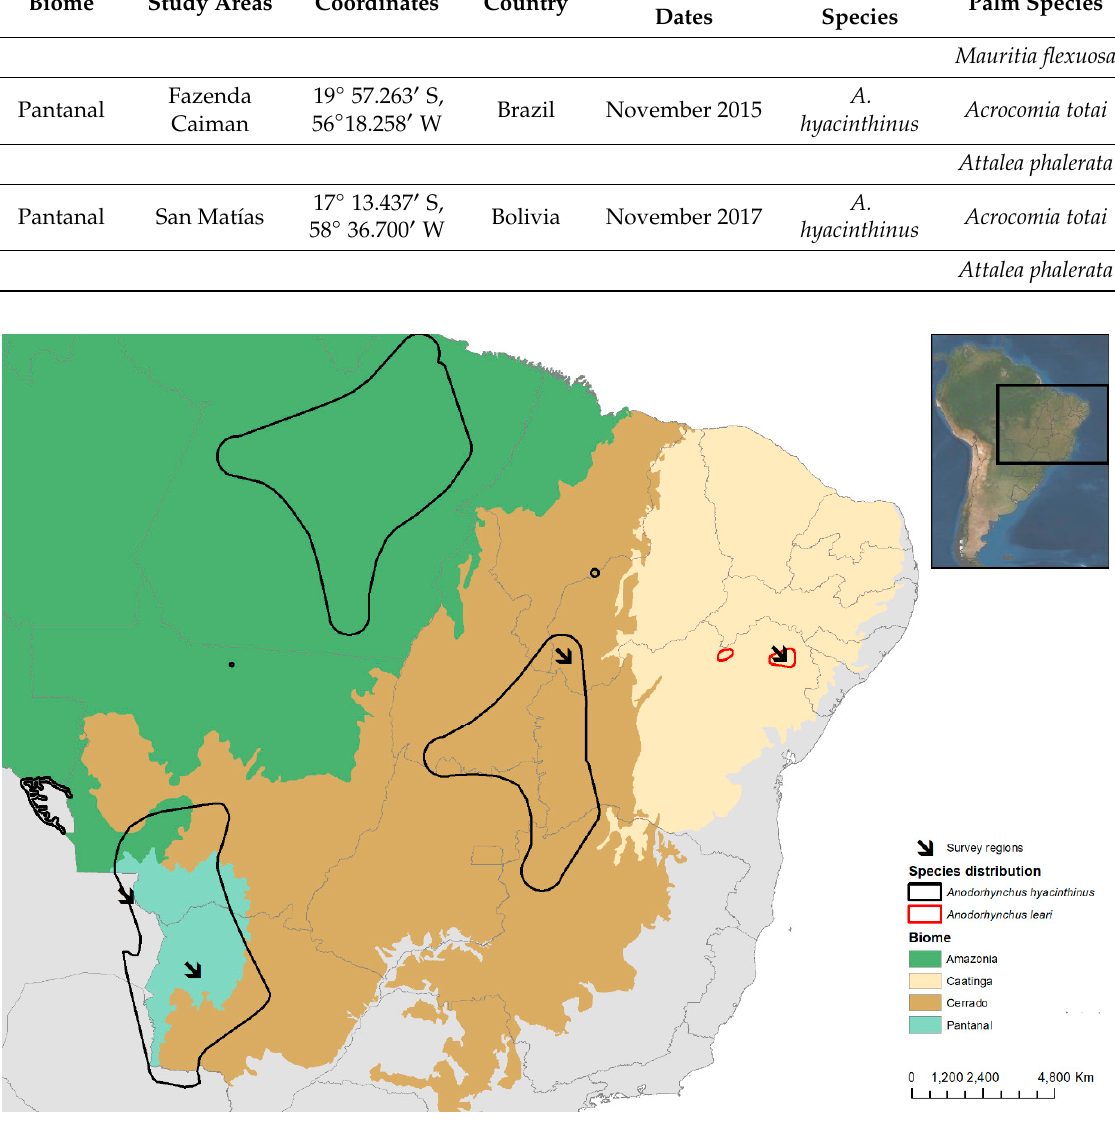
Figure 1. Global distribution of the two macaw species studied in Brazil and Bolivia, biomes, and location of the four study areas (arrows). Maps were generated using ArcGIS v.10.5. (ESRI, Redlands, USA), using biome layers [39], Landsat-4 images [40], and species distributions available [33,34].